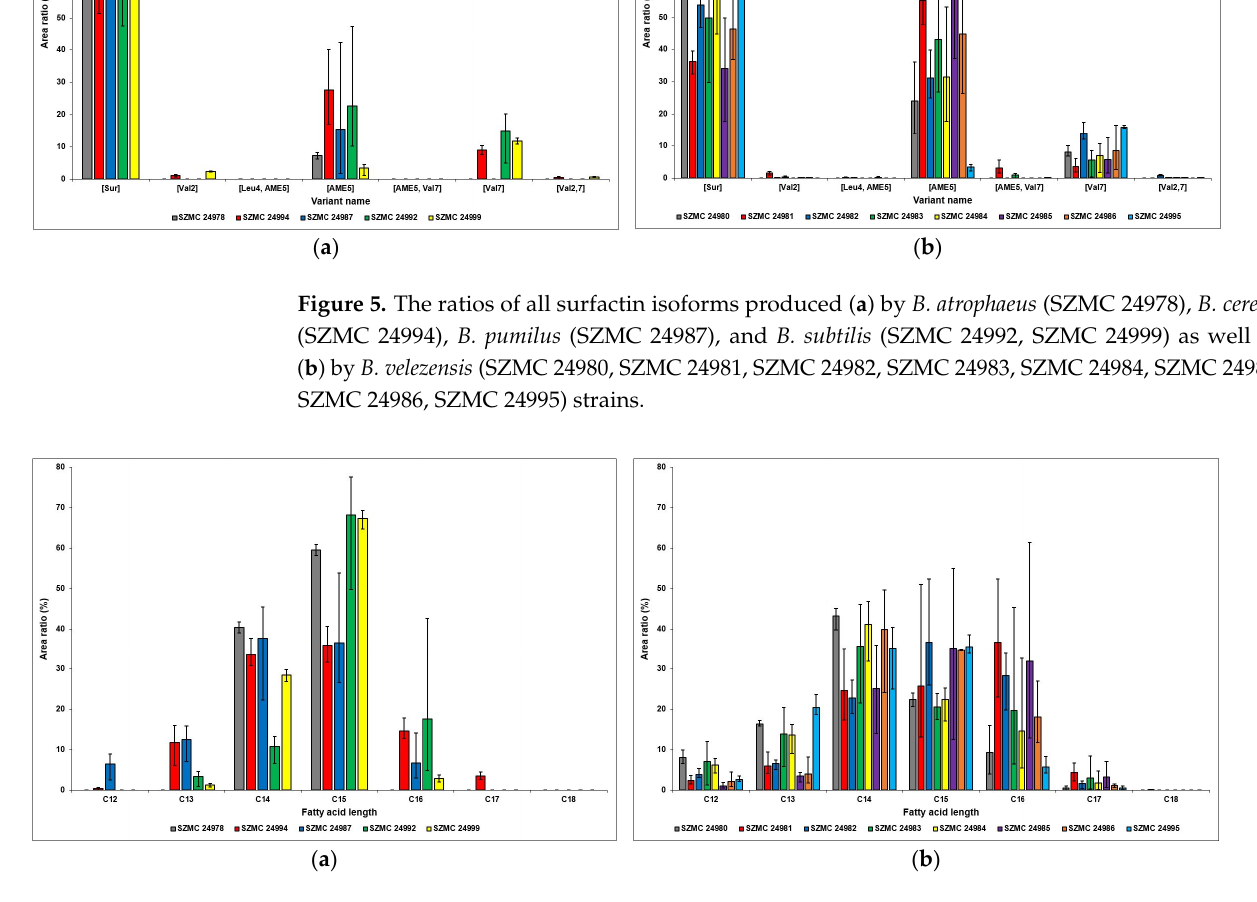
Figure 6. The ratios of all surfactin homologues produced ( a ) by B. atrophaeus (SZMC 24978), B. cereus (SZMC 24994), B. pumilus (SZMC 24987), and B. subtilis (SZMC 24992, SZMC 24999) as well as ( b ) by B. velezensis (SZMC 24980, SZMC 24981, SZMC 24982, SZMC 24983, SZMC 24984, SZMC 24985, SZMC 24986, SZMC 24995) strains.